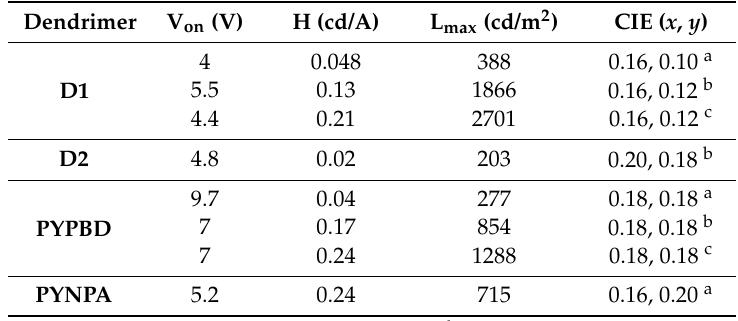
Table 2. Device performances of